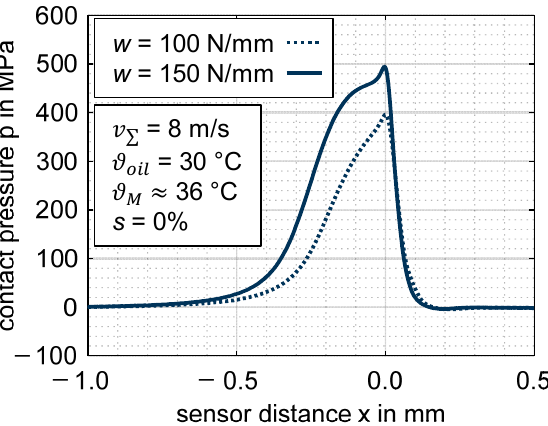
Figure 11. Contact pressure p for different line loads w = {100; 150} N/mm for the steel EHL contact ZrO 2 /steel (slip ratio s = 0%, sum velocity 𝑣 ∑ = 8 m/s, oil temperature 𝜗 (cid:3042)(cid:3036)(cid:3039) = 30 °C, MIN100). Temperature measurements are performed for w = 150 N/mm, 𝑣 ∑ = 8 m/s, and s = {0;